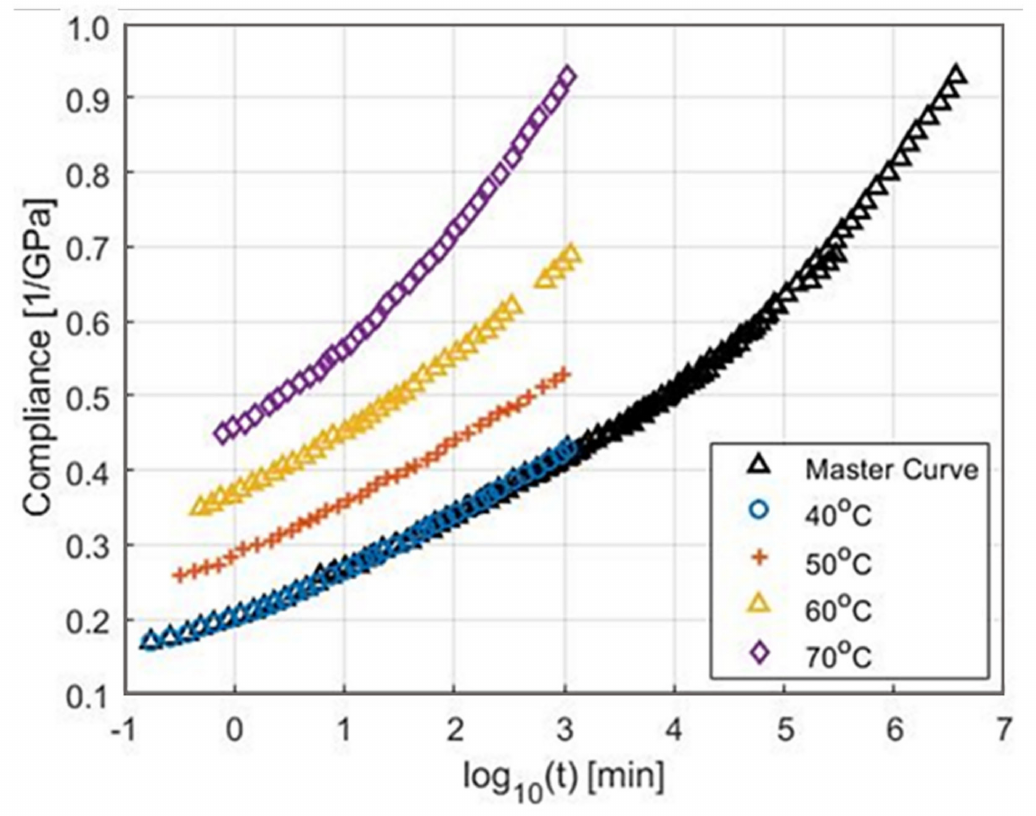
Figure 4. Time-temperature superposition experimental data, reproduced from [65]. Data were collected from tensile tests for an FRP composite at various temperatures and shifted along the time axis to create a master curve for a reference temperature of 40 ◦